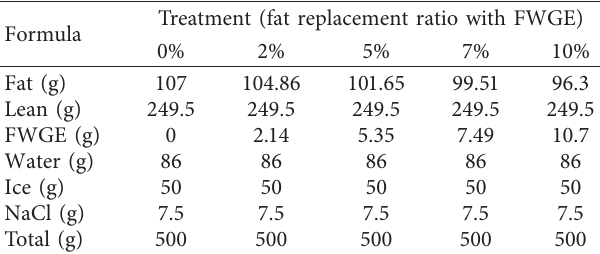
Table 2: Formulation of emulsified sausages.